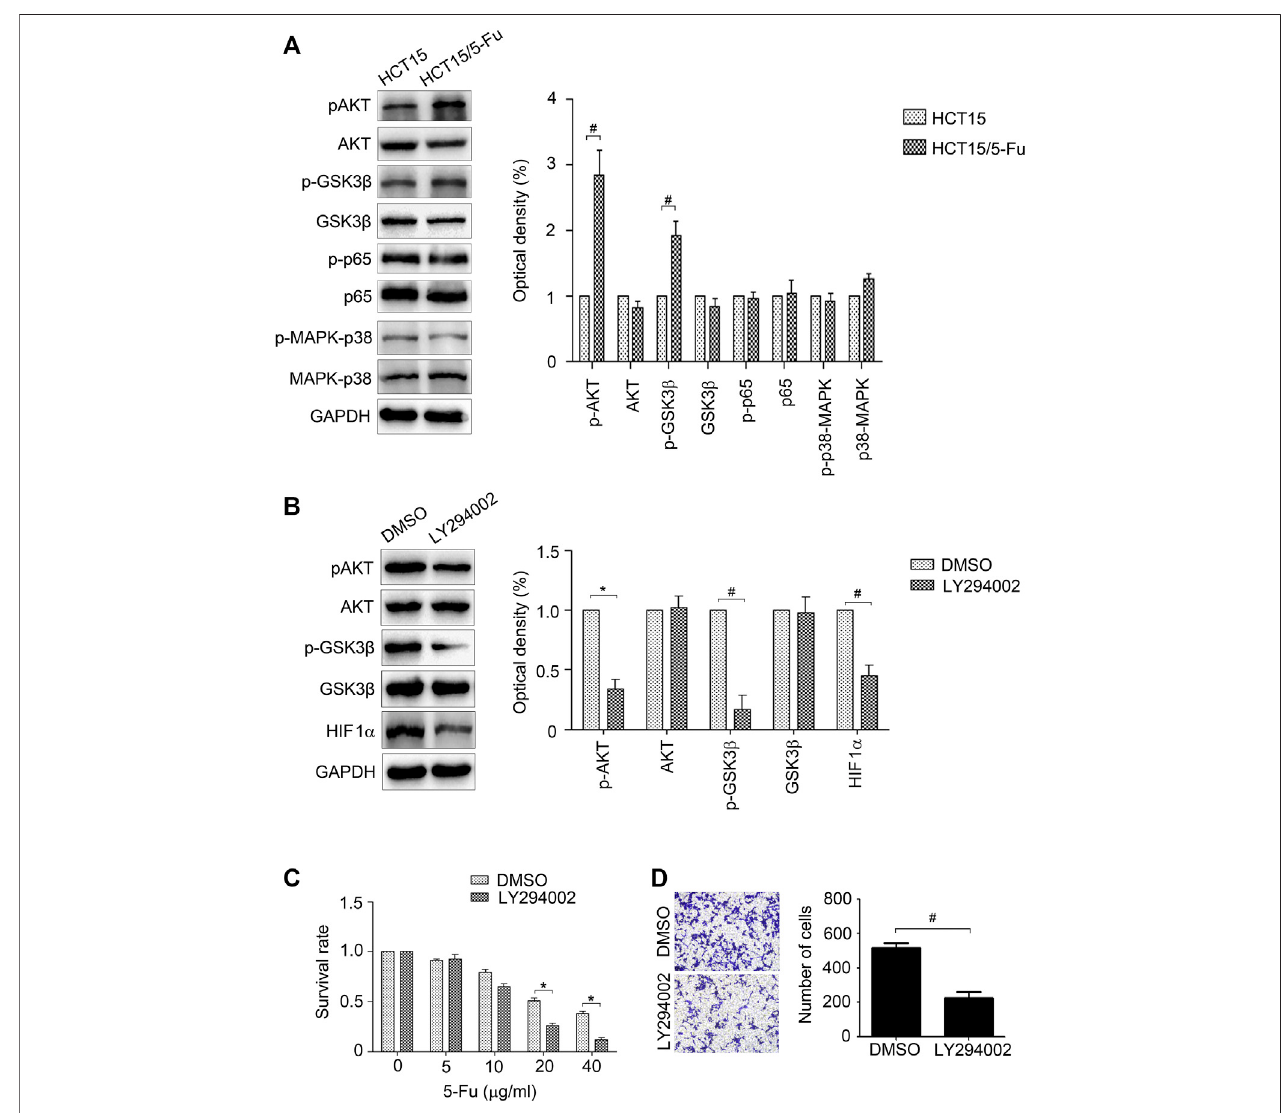
FIGURE 6 | AKT/GSK3 β signal is crucial for the aggressive phenotype of 5-Fu resistant CRC cells. (A) The expression of p -AKT, AKT, p -GSK3 β , GSK3 β , p-p65, p65, p-p38-MAPK and p38-MAPK in HCT15 and HCT15/5-Fu cells were detected by WB. (B) HCT15/5-Fu cells were treated with LY294002 (20 μ M) for 24 h, the expression of p -AKT, AKT, p -GSK3 β , GSK3 β and HIF1 α were examined by WB. (C) HCT15/5-Fu cells were treated with LY294002 (20 μ M) or DMSO for 24 h, then treated with increasing concentrations of 5-Fu for 48 h. CCK8 assay was used to quantify the viable cells. (D) Transwell assay was performed to examine the migrationofHCT15/5-FucellstreatedwithLY294002(20 μ M)orDMSOfor24 h.Datarepresentedasmean±SDwerefromthreeindependentexperiments.*: p < 0.05, #: p <